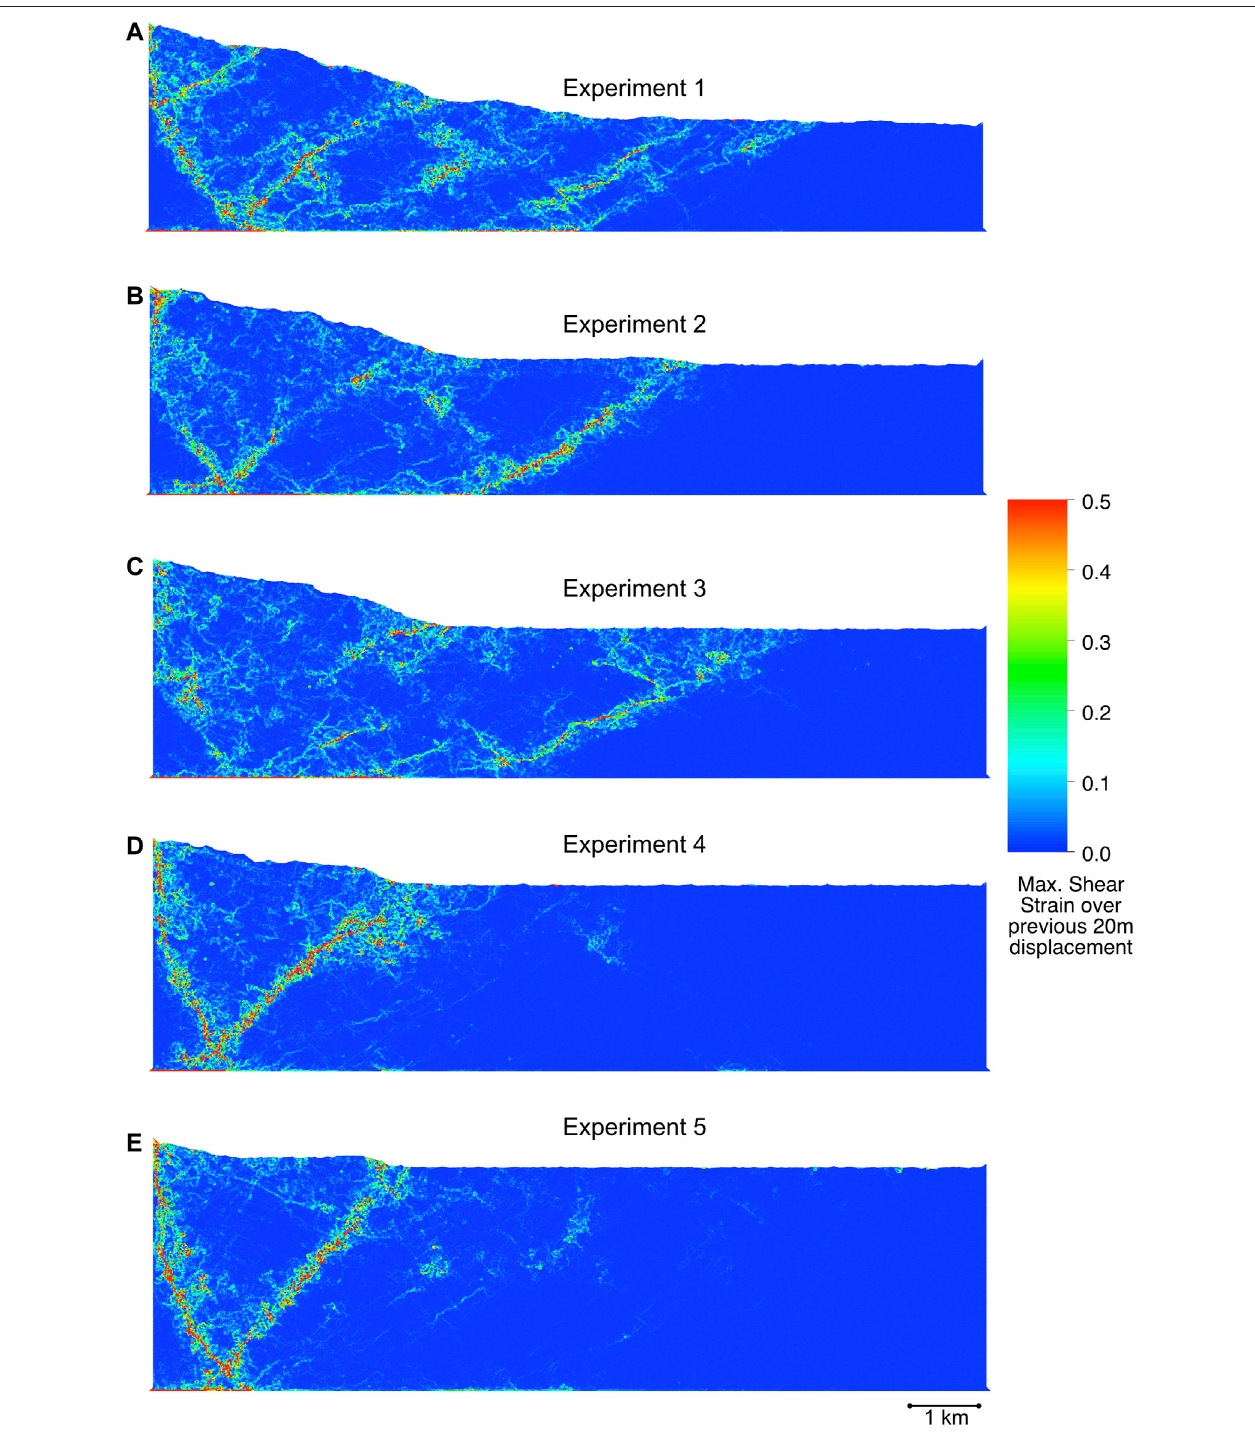
FIGURE 8 | Incremental maximum shear strain in all models over the previous 20 m of displacement at 20% shortening. Maximum shear strain colour scale is included to the right. See text for discussion.